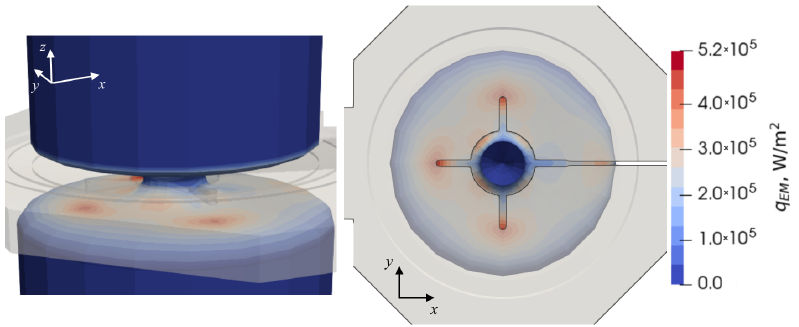
Figure 5. 3D high-frequency electromagnetically induced heat sources on silicon surfaces used for 3D melt flow simulations. The one-turn inductor is shown in grey.